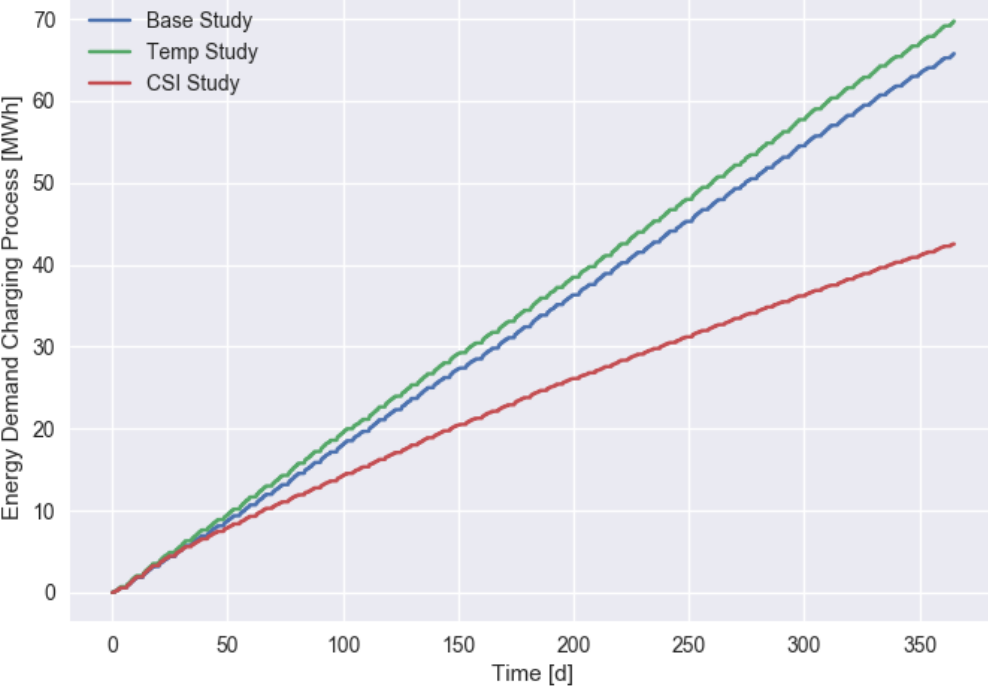
Figure 5. Accumulated energy demand over time for different agent scenarios (with P Base = 30